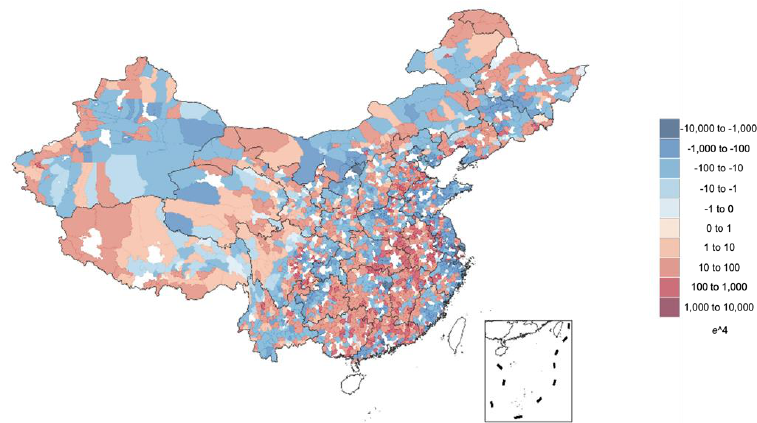
Figure 5. The prediction error map of county-level GDP in 2018. White areas in the map represent regions where data are missing. Due to the large area of the Chinese Mainland, there are a few regions where images are either missing or of poor quality (Hainan Island, for instance). Nevertheless, the number of counties covered by the images we gained is enough for this study.